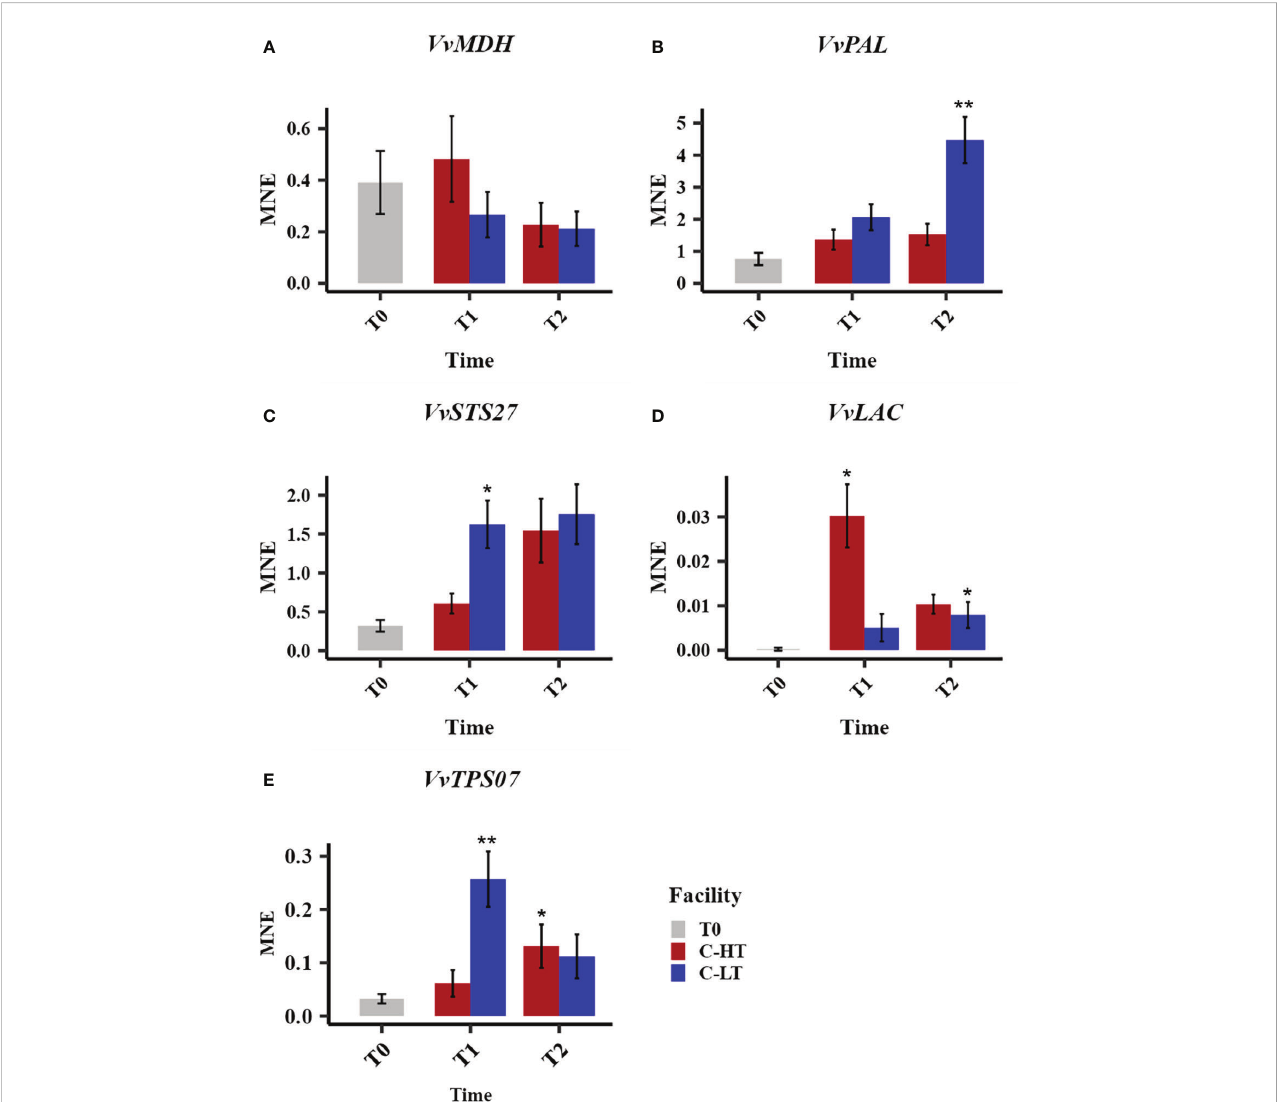
FIGURE 7 Relative expression of quality-related genes during withering in the C-HT and C-LT rooms. Expression pro fi les of malate dehydrogenase ( VvMDH , A ), phenylalanine ammonia-lyases (VvPAL, B ), stilbene synthase ( VvSTS27 , C ) laccase ( VvLAC , D ) and terpene synthase ( VvTPS07 , E ) genes in grape sampled during withering in the C-HT and C-LT rooms. Error bars represent standard errors (n=3). Blue colour indicates the C-LT condition; red colour the C-HT condition. Asterisks represent statistically signi fi cant difference between partially withered grapes (T1 and/or T2) and grapes at harvest (T0), based on t-test (p ≤ 0.05 = *; p ≤ 0.01 =